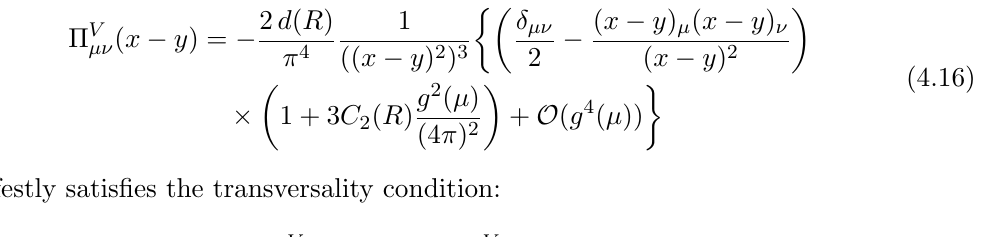
results reported in [13] and ancillary (cid:12)les 12 for the vector correlator in coordinate space with N = 3 and fermions in the fundamental, up to and including O ( g 6 ( (cid:22) )), can be rewritten in terms of g ( j x (cid:0) y j ) in eq. (4.12)